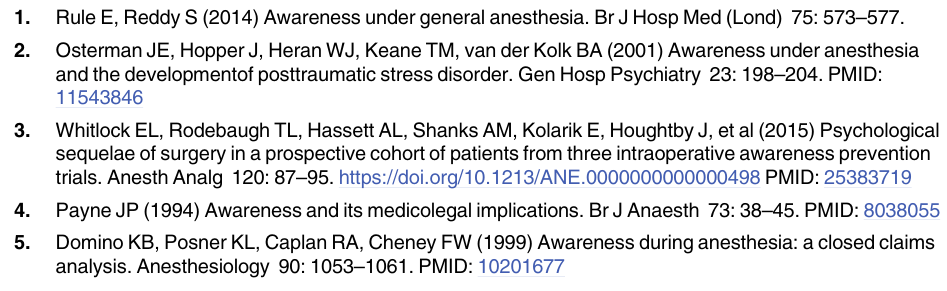
S2 Table. Codebook for minimal